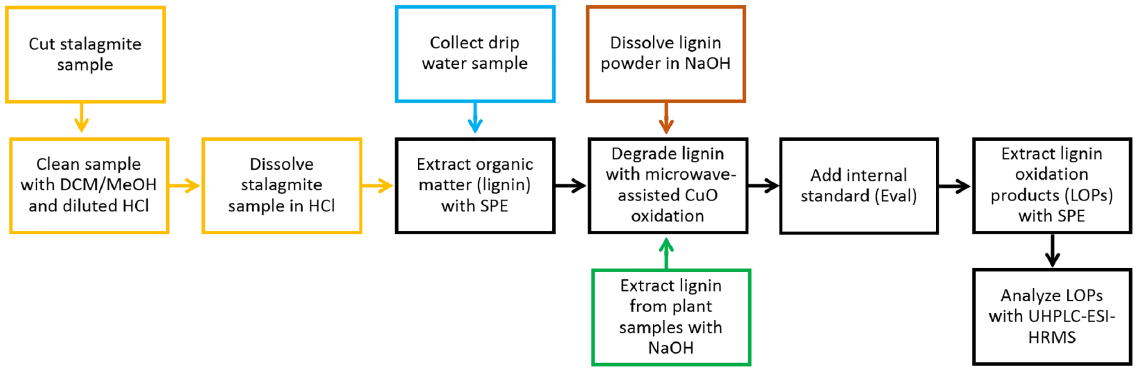
Figure 1. Process chart of the overall sample preparation procedure. A detailed description of the individual steps is given in Sect.